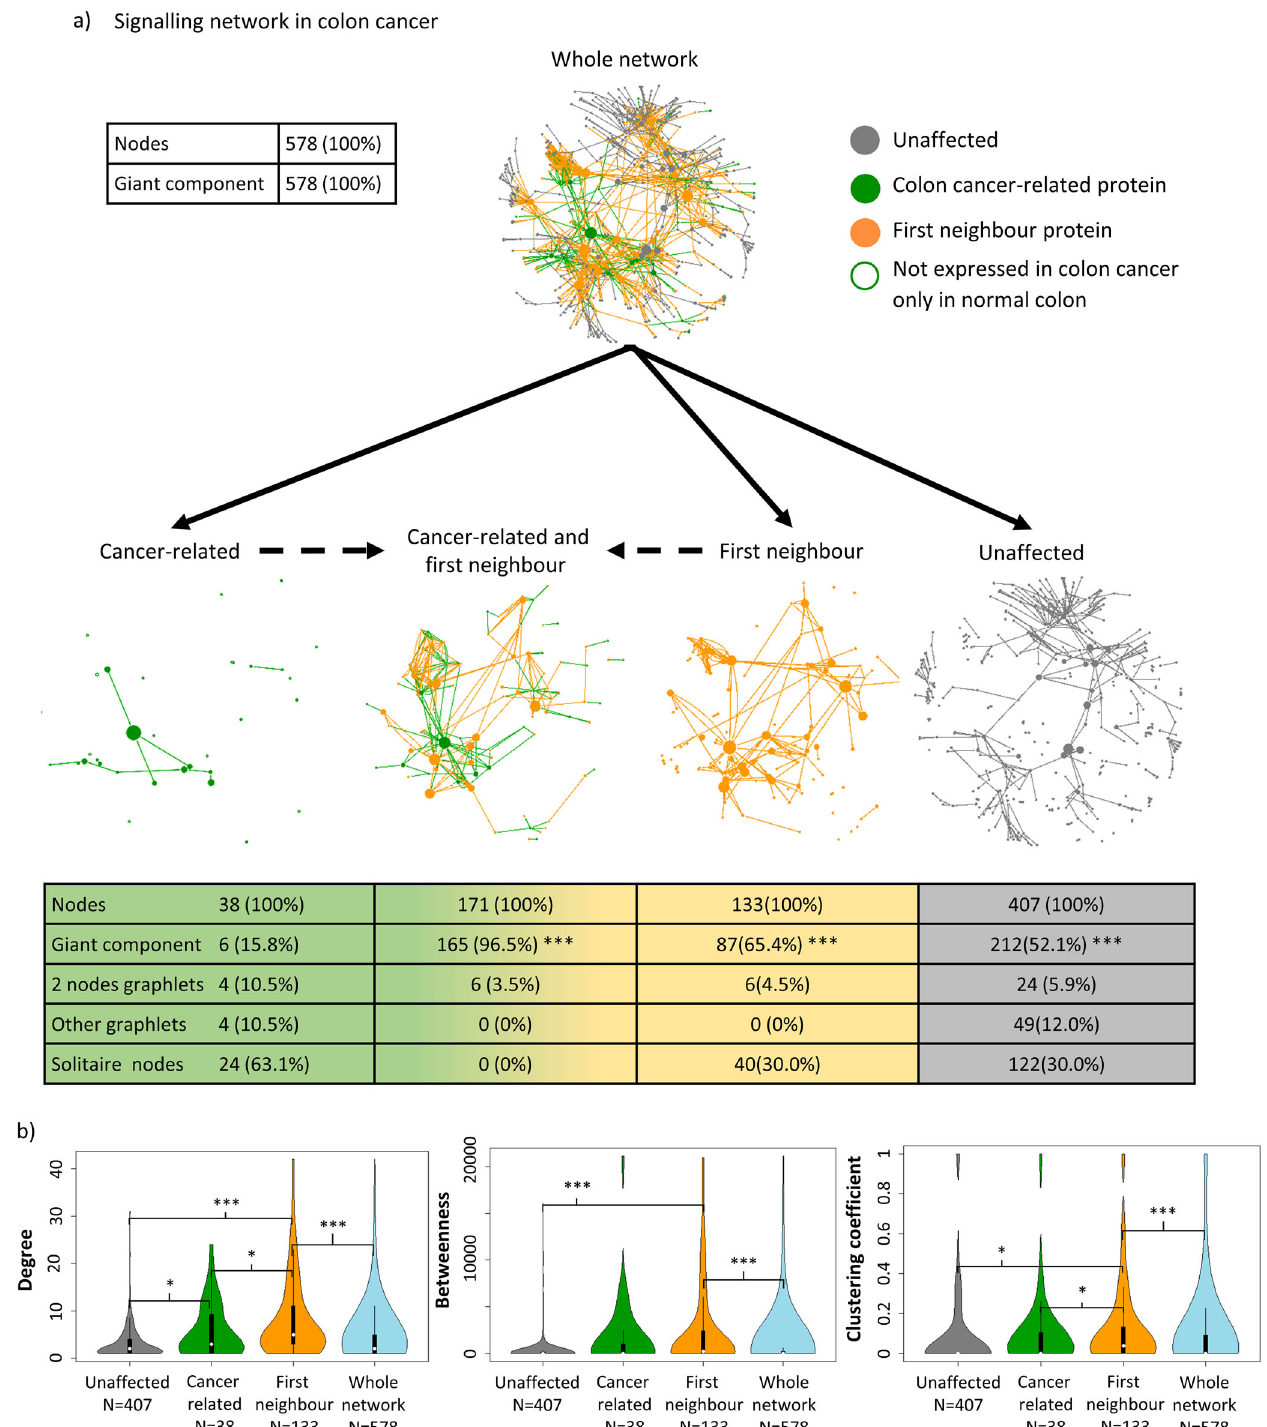
Fig. 1 First neighbours have a central position in cellular signalling networks. a The signalling network of colon cancer (interactions based on the SignaLink resource). Node sizes are proportional to their betweenness centrality network parameter. Green nodes represent cancer- related proteins, orange nodes are their fi rst neighbours and grey nodes represent the proteins that do not belong to any of these categories (here termed as “ unaffected ” proteins). Based on cancer-relatedness, sub-graphs have been created, with their major network properties shown below them. Note the different ratio of nodes in the giant component, which is the largest connected graph. (Exact test *** p < 0.001) b Distribution of network topological properties for each subgraph: degree (local centrality), betweenness centrality (global centrality), and clustering coef fi cient (neighbourhood connectivity). White dots represent median values, boxes stretch from the 25th percentile to the 75th percentile, and whiskers are twice the length of the boxes. Wilcoxon rank sum tests have been used for statistical testing, with the whole network serving as control. The level of signi fi cance is represented using the following scale: * p < 0.05, ** p < 0.01, *** p <